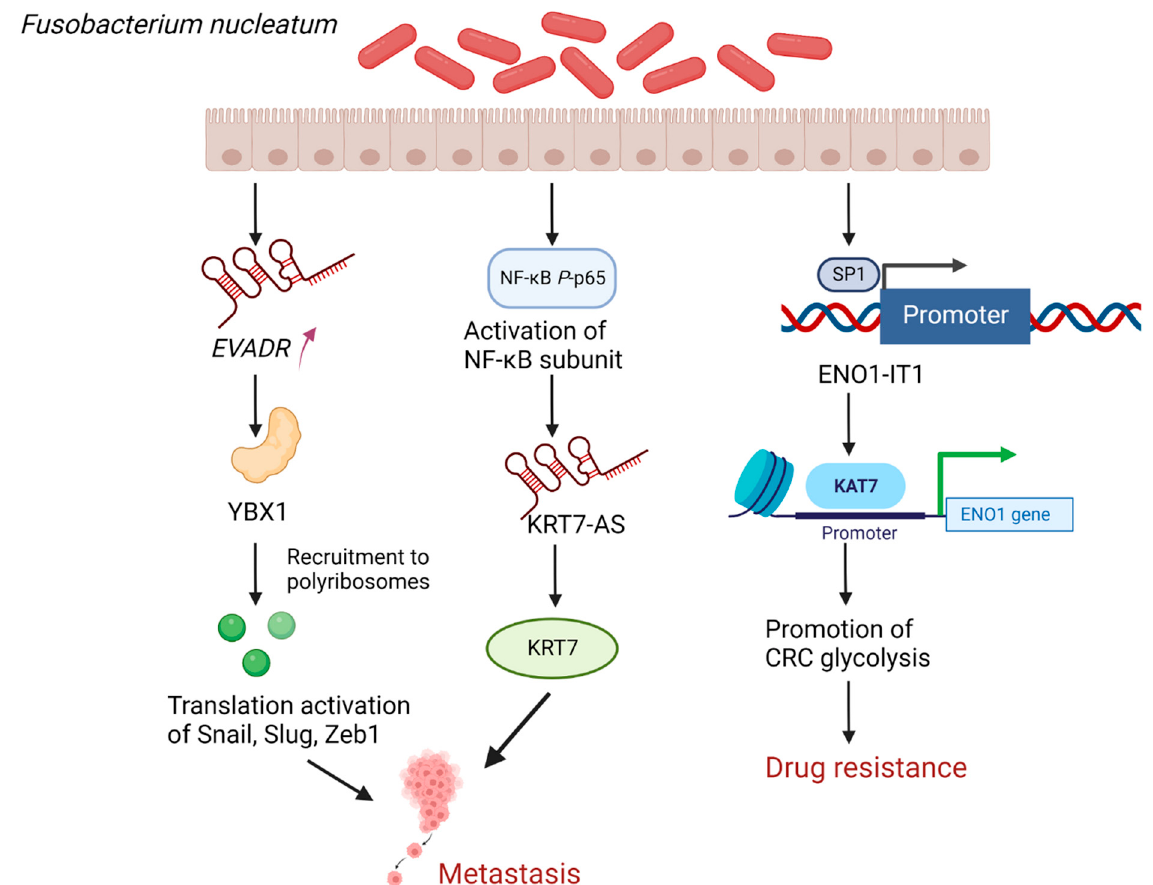
Figure 2. F. nucleatum promotes CRC metastasis as well as enhances drug resistance by upregulating EVADR , KRT7-AS, and ENO1-IT1. Elevated EVADR directs RBP YBX1 to recruit EMT-related factors, including Snail, Slug, and Zeb1, to polyribosomes, and enhances the translation of these EMT-related factors, thereby inducing EMT, ultimately facilitating colorectal cancer metastasis. F. nucleatum infection activates the NF- κ B pathway, and activated NF- κ B P -p65 (activated NF- κ B subunit) may upregulate KRT7-AS by increasing the transcriptional activity of KRT7-AS, then activating the downstream target of KRT7-AS, KRT7, which regulates CRC metastasis. F. nucleatum